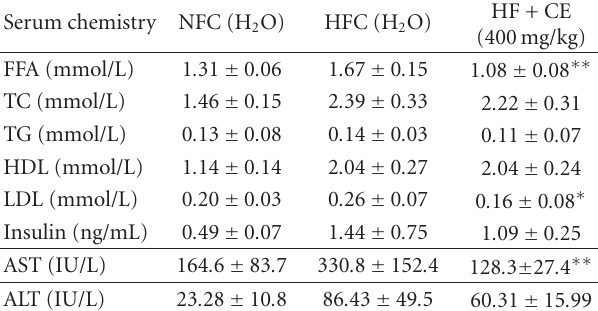
Table 1: E ff ects of CE on serum chemistry of DIO mice. NFC: normal-fat diet control; HFC: high-fat diet control. The data are represented as mean ± SE, n = 5 for each group. ∗ P < . 05, ∗∗ P < . 01 compared to